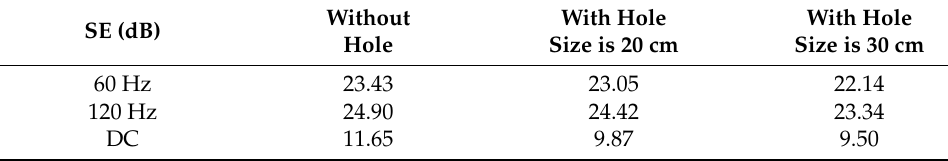
Table 8. Comparison between shielding effectiveness in different hole